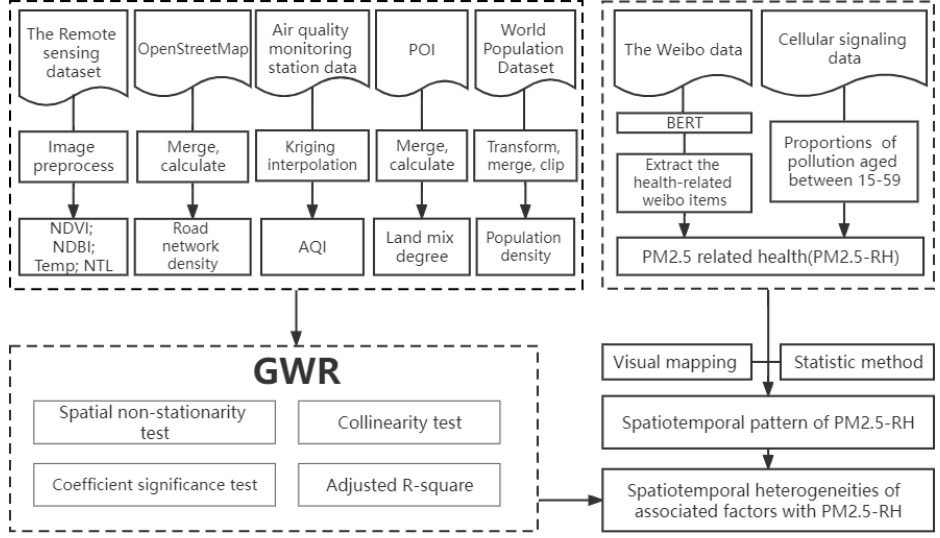
Figure 2. The research framework.